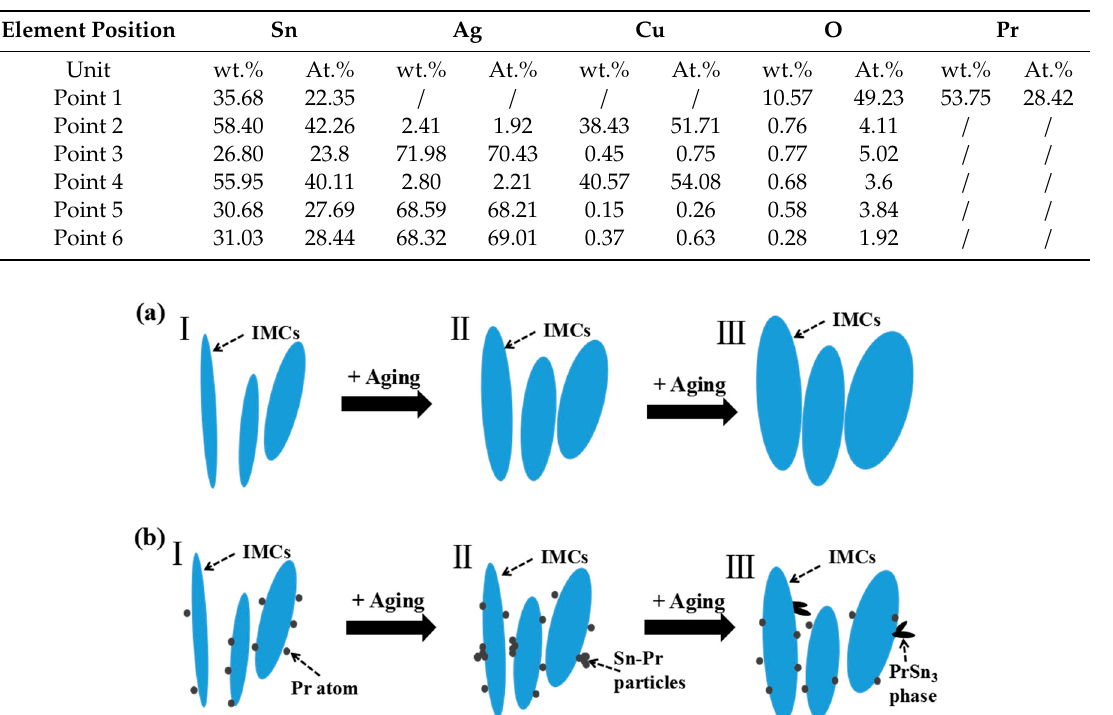
Table 1. EDS analyzed results of related IMCs formed in the aged SAC0307-0.05Pr solder.